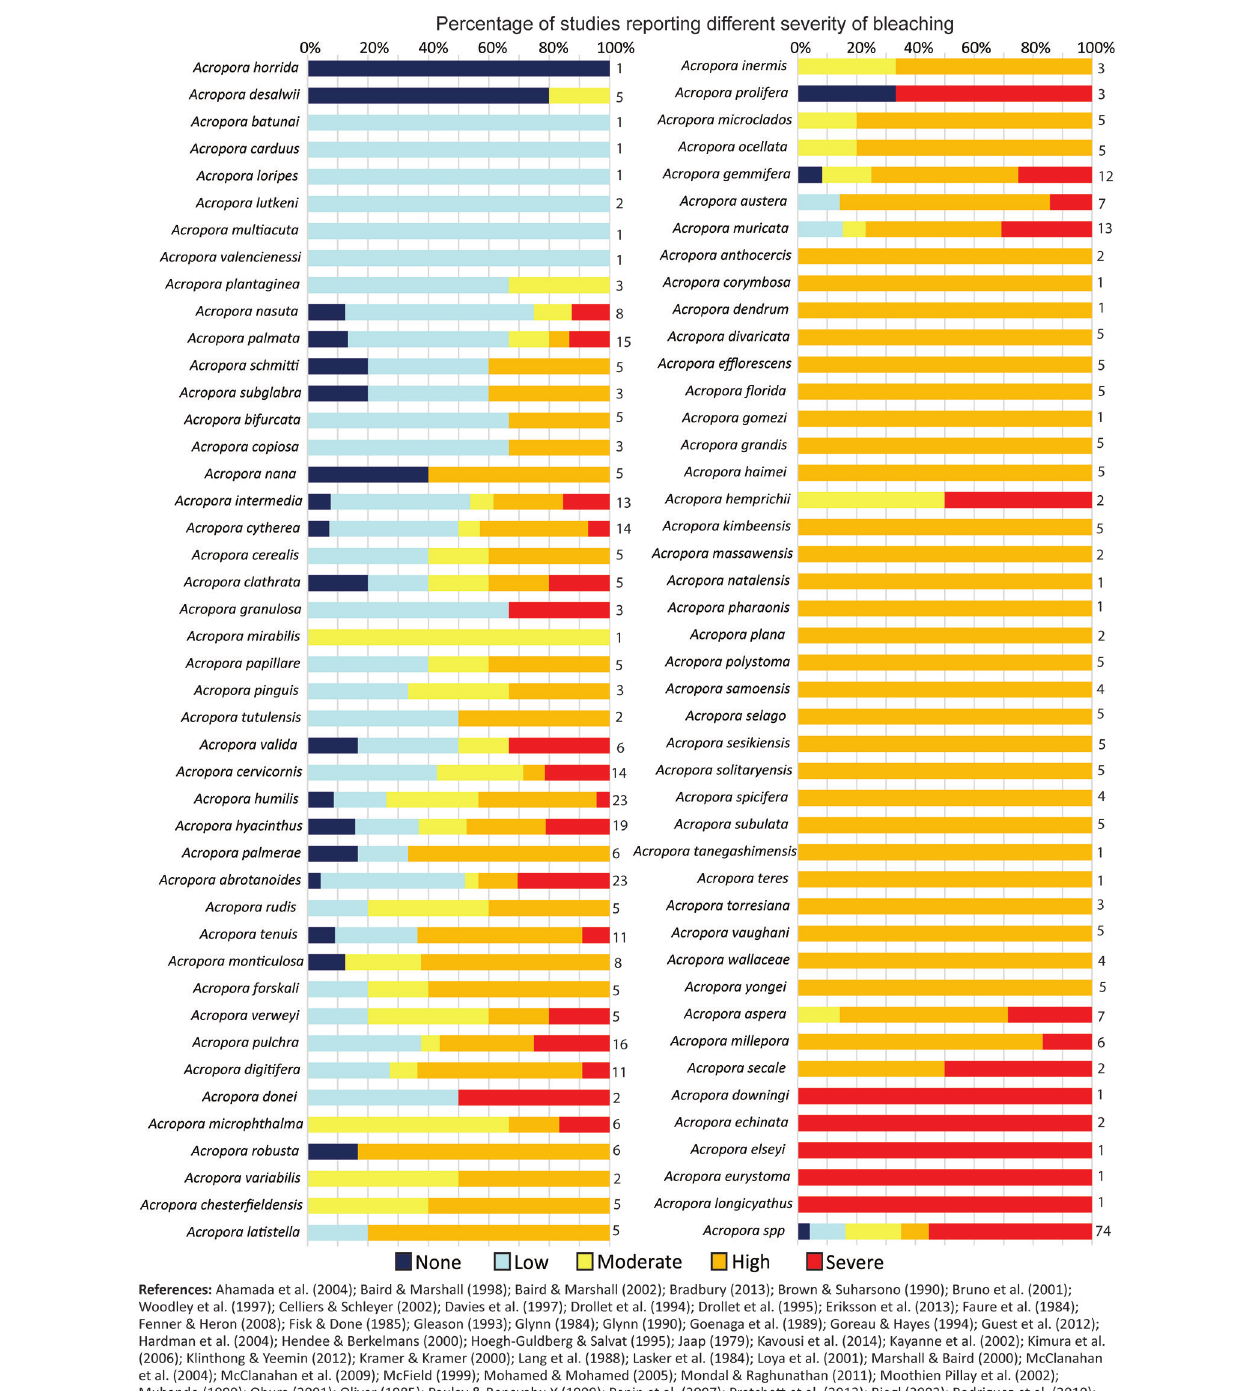
Frontiers in Marine Science |